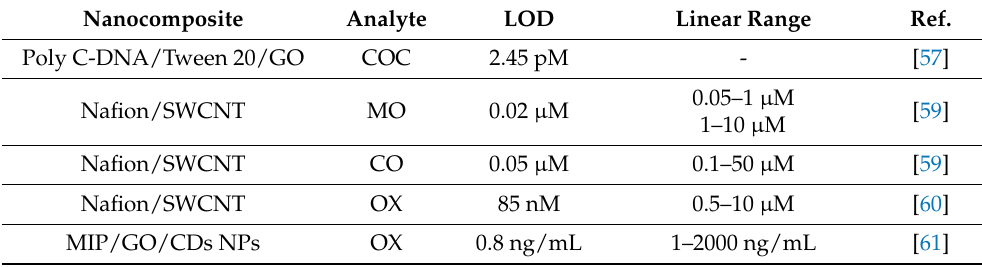
Table 1. Comparison of carbon-based polymeric nanocomposites used in forensic sciences for the determination of different